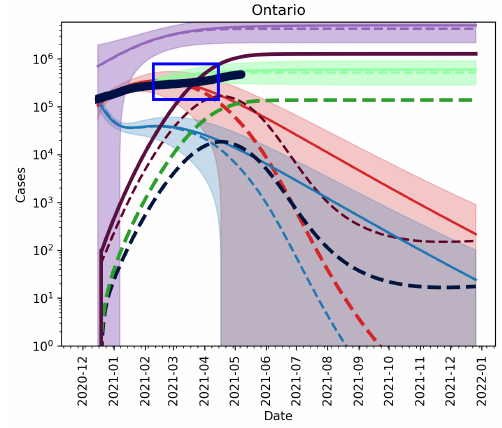
Figure A2. Figure 6a augmented with data up to 7 May 2021. The model is still only fit to data up to 11 January 2021. We see that the line fit (cumulative known wildtype cases) is still relatively close 4 months out. As before, green represents the cumulative known cases, purple is the total incidence, red is active mild cases, and blue is active severe cases. Dark lines are mutant compartments, and light colours are wildtype. Dashed lines are the extended scenario, and solid lines the original fit without a separation of wildtype and mutant. The light green line is what is being fit by the model. We see some anomalous behaviours in the extension due to the period of lockdown–relaxation cycles in Ontario. While the log scale obfuscates some detail, the consequence of these lockdown–relaxation cycles not being present in thee model causes an over-estimation on the order of 10 4 cases.